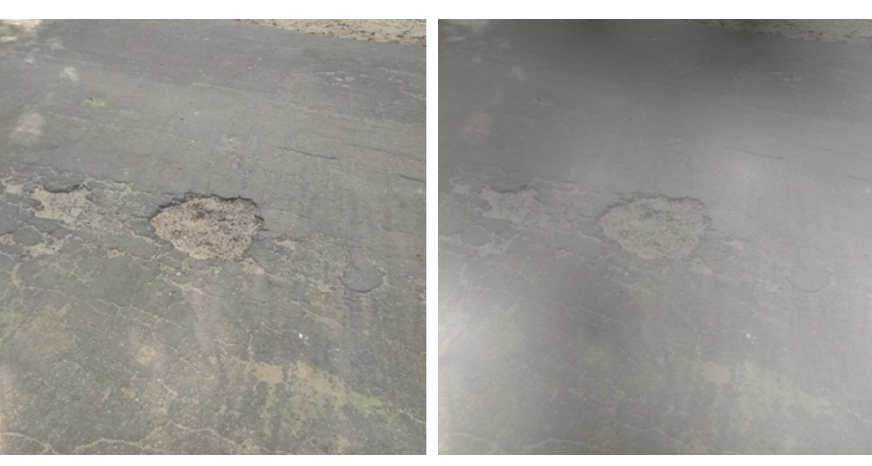
Figure 7. Comparison of pothole photos before and after